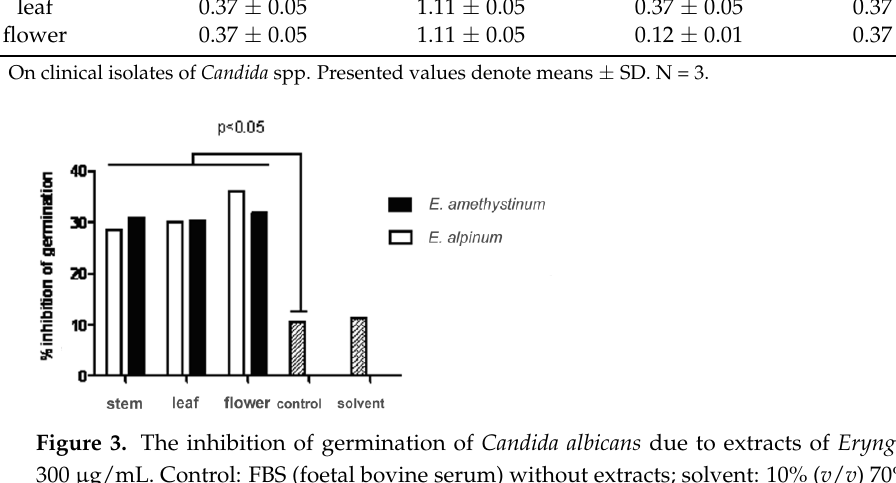
Figure 3. The inhibition of germination of Candida albicans due to extracts of Eryngium spp. at 300 µ g/mL. Control: FBS (foetal bovine serum) without extracts; solvent: 10% ( v / v ) 70% ethanol in FBS. N = 3.